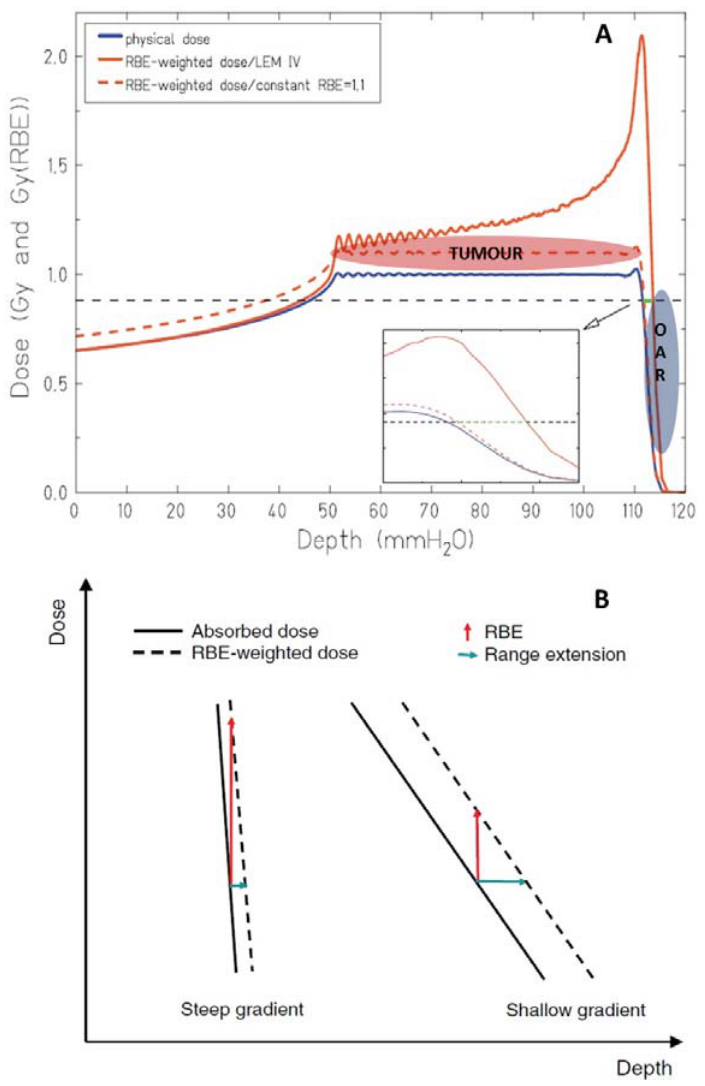
Figure 3. In panel ( A ) physical and RBE-weighted dose are shown, as obtained with a constant and with a variable RBE. Special emphasis is given to the differences at the distal fall-off, where OAR might be located. In panel ( B ) the different impact in terms of range extension that can be expected when comparing steep and shallow dose gradients is shown. Adapted from Grün et al.